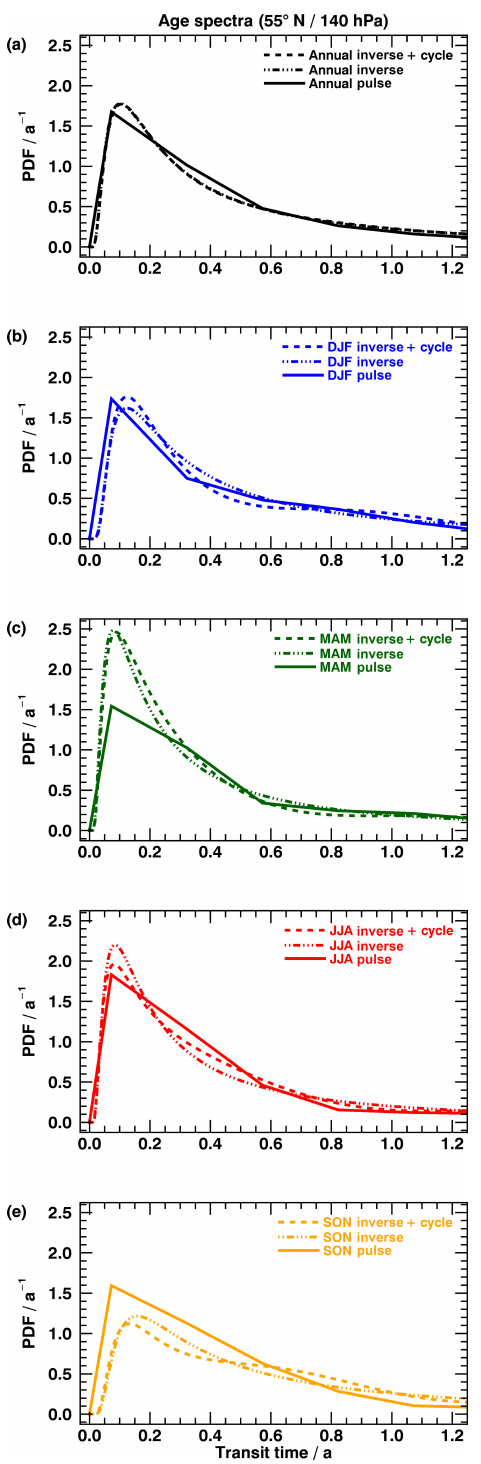
Figure 6. Same as Fig. 4, but at 55 ◦ N and